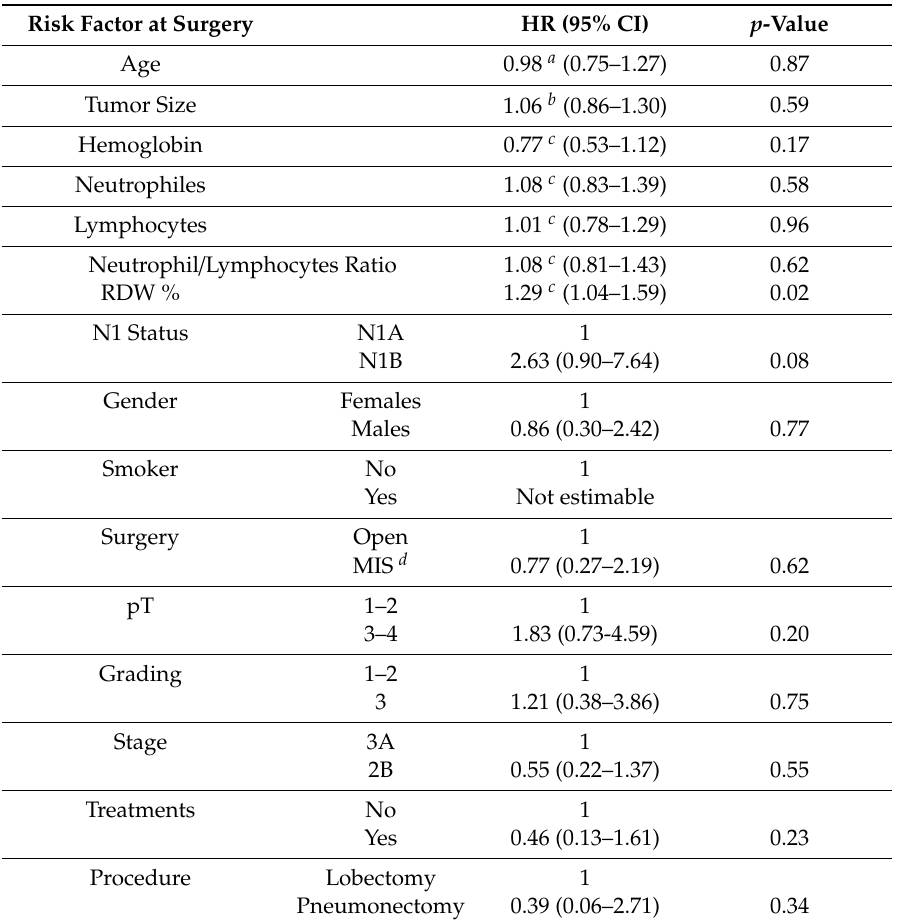
Table 5. Disease-free survival univariate analysis.